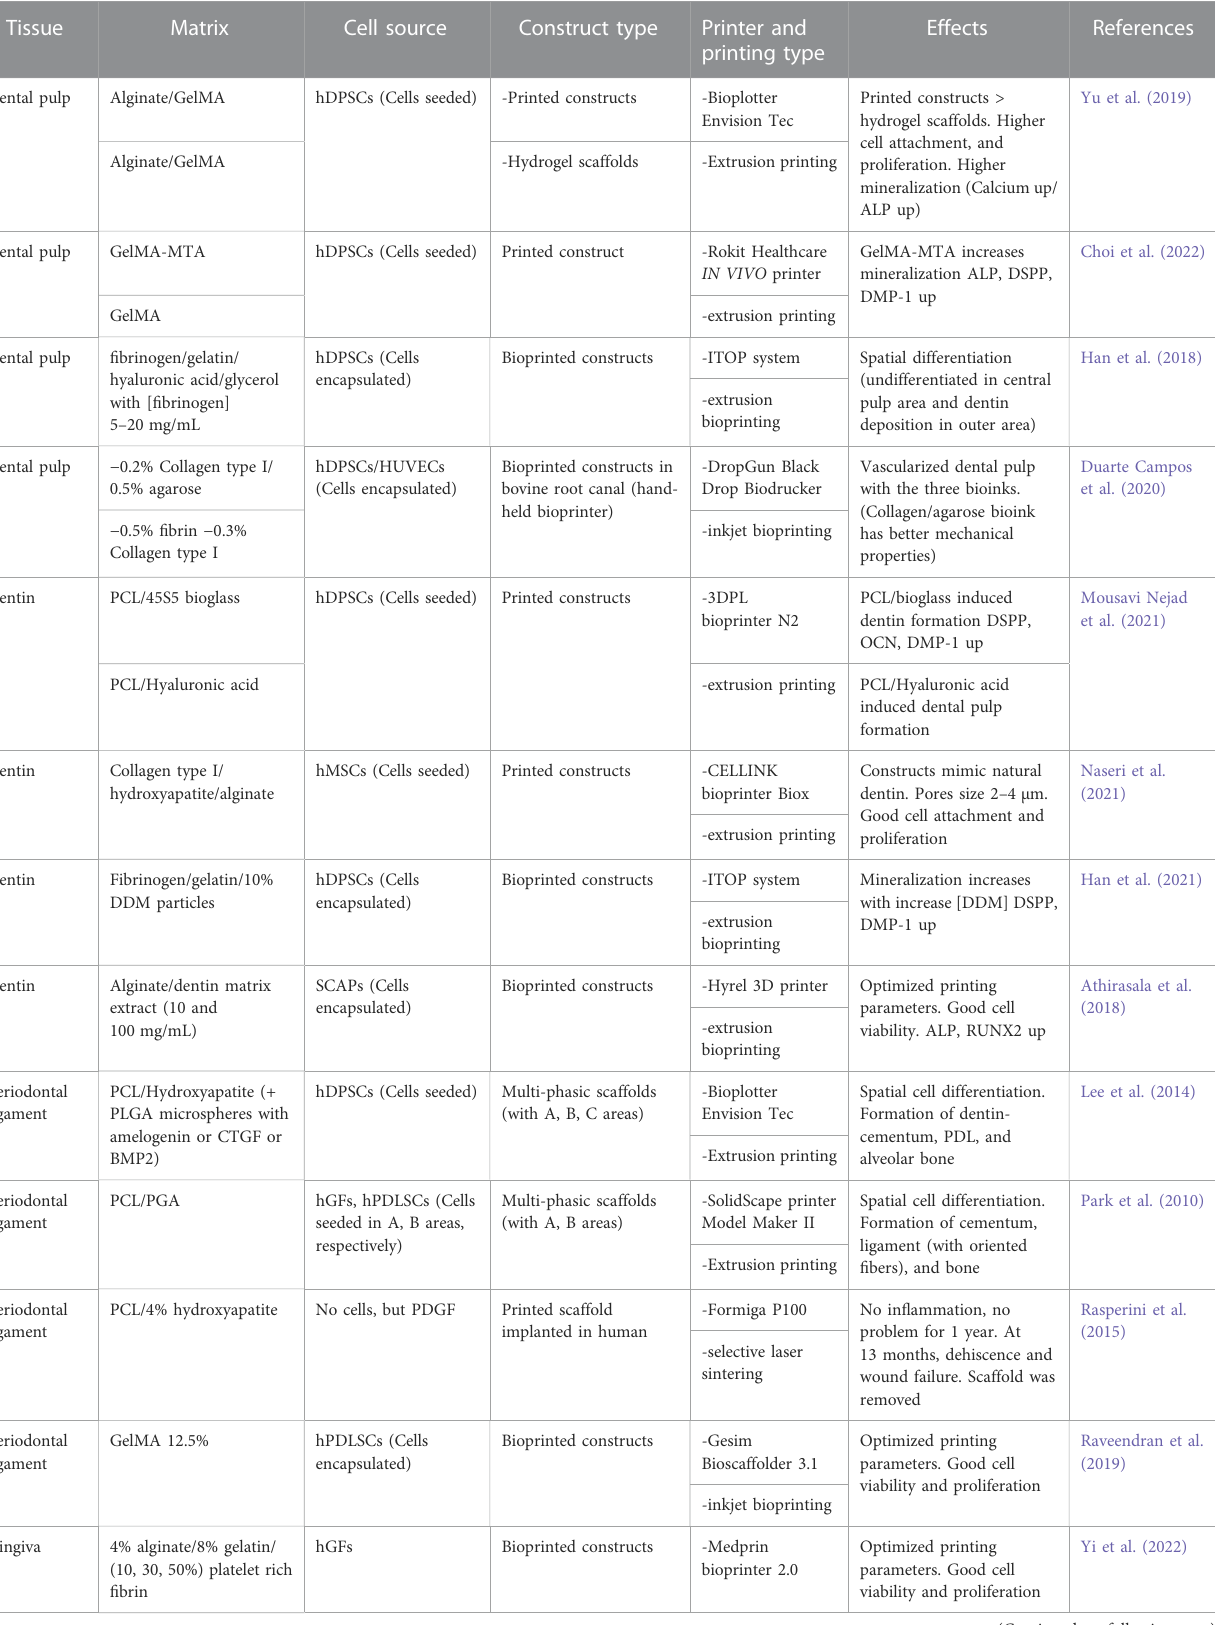
TABLE 1 Overview of bioinks used for dental alveolar tissue regeneration with their